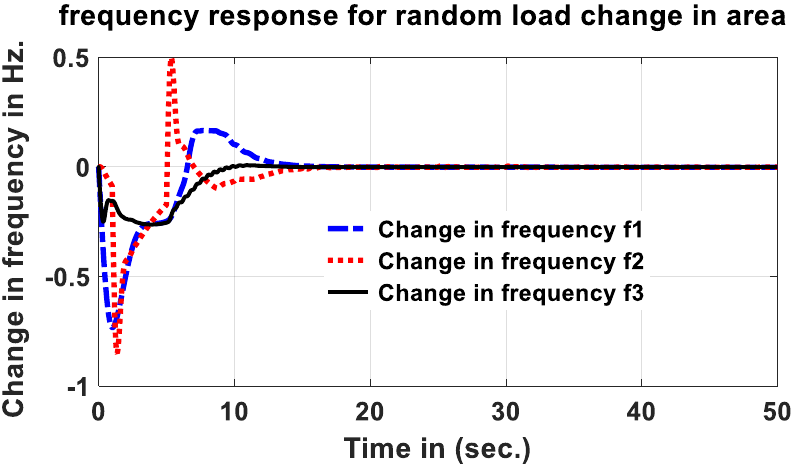
Figure 24. Change in frequency responses of area 1, area 2, and area 3 for random load change in area 2 only.